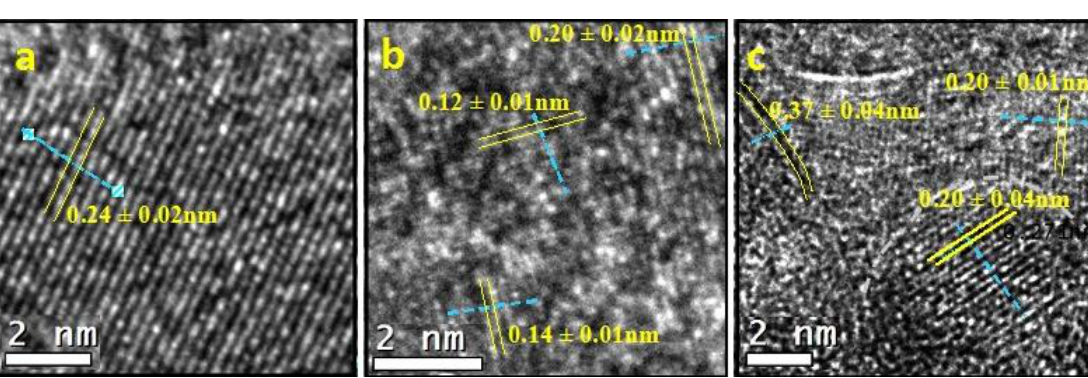
Figure 4. High resolution transmission microscopy (HRTEM) micrographs of ( a ) A; ( b ) AFSG and ( c )